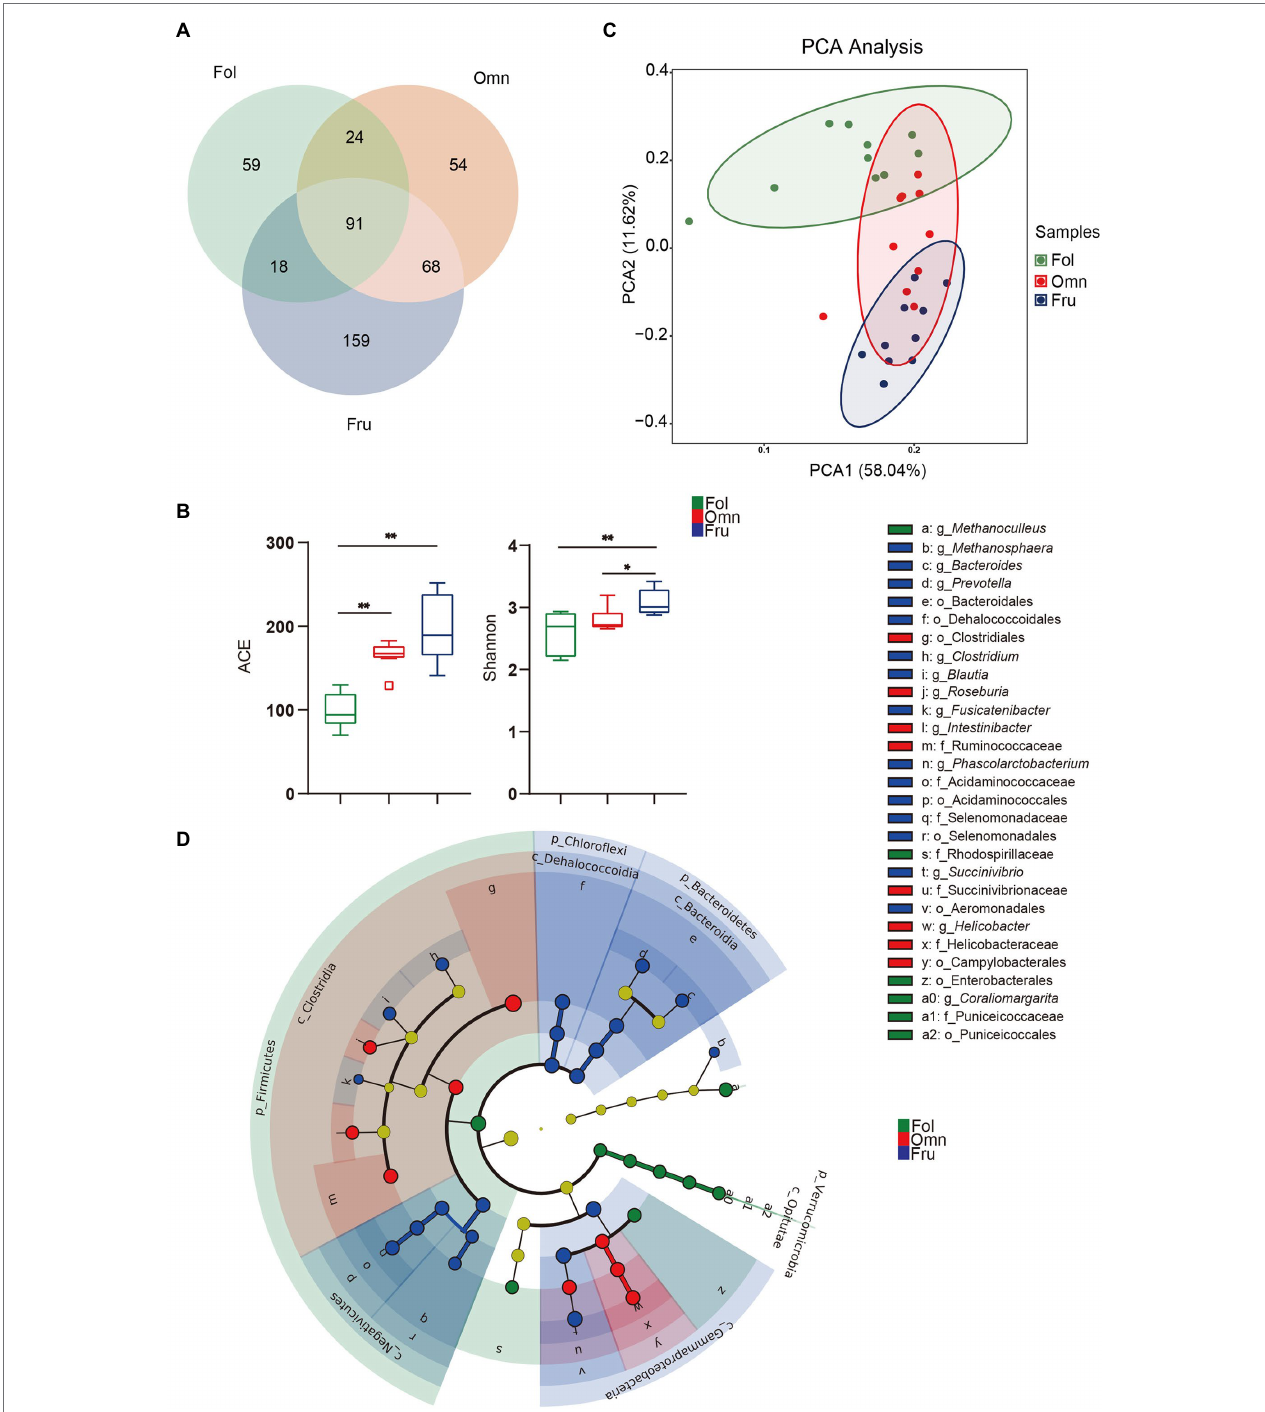
FIGURE 1 | Gut microbiome structure in three primate groups. (A) Venn diagram at the species level. (B) Box-plots of alpha diversity (ACE and Shannon index) at the species level. (C) Microbiome beta diversity (Principal component analysis, PCA) plot among primates at the species level. (D) Cladogram of differential microbial prevalence identified by Linear discriminant analysis (LDA), effect size (LEfSe) analysis (LDA score > 4, one against all), from the phylum (innermost ring) to genus (outermost ring). Differentiated bacterial taxa are marked by lowercase letters. Each small circle at different taxonomic levels represents a taxon at that level, and the diameter of the circle is proportional to relative abundance. Taxa with no significant difference are yellow. Differentiated taxa are colored according to the group with the highest species abundance. Colors represent groups and nodes are colored according to the communities that play an important role in the group represented by the color. A value of p < 0.05 was considered statistically significant. * p < 0.05; ** p <